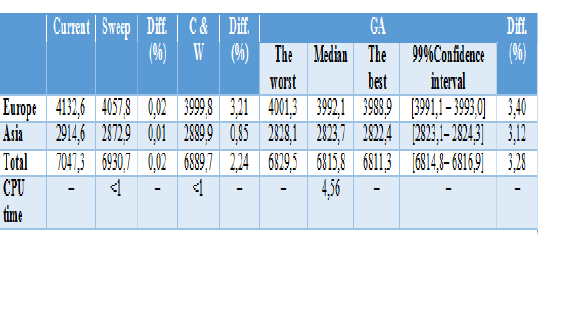
Table 3 : Comparison of the solutions.